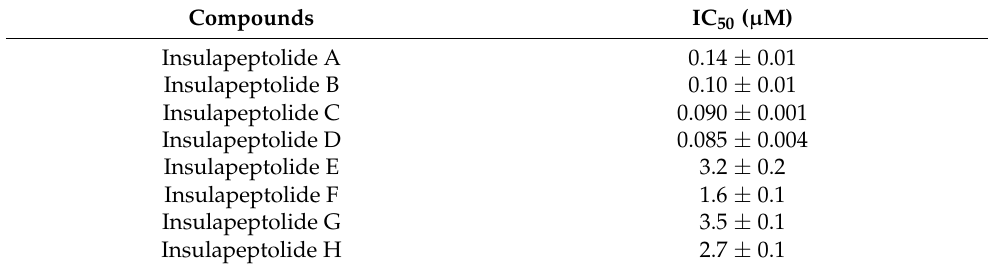
Table 2. IC 50 values of Insulapeptolides A–H for the inhibition of human leukocyte elastase (HLE) [26].